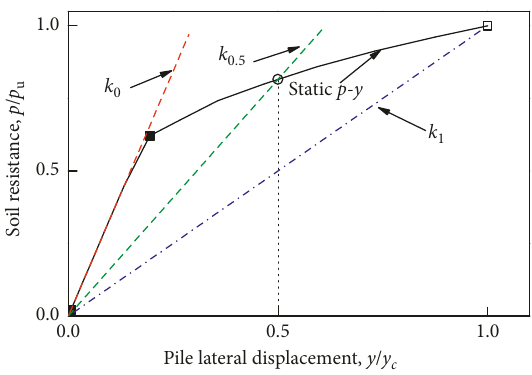
Figure 15: Linear approximation of the soil stiffness. Figure 16: Soil linear stiffness estimation.